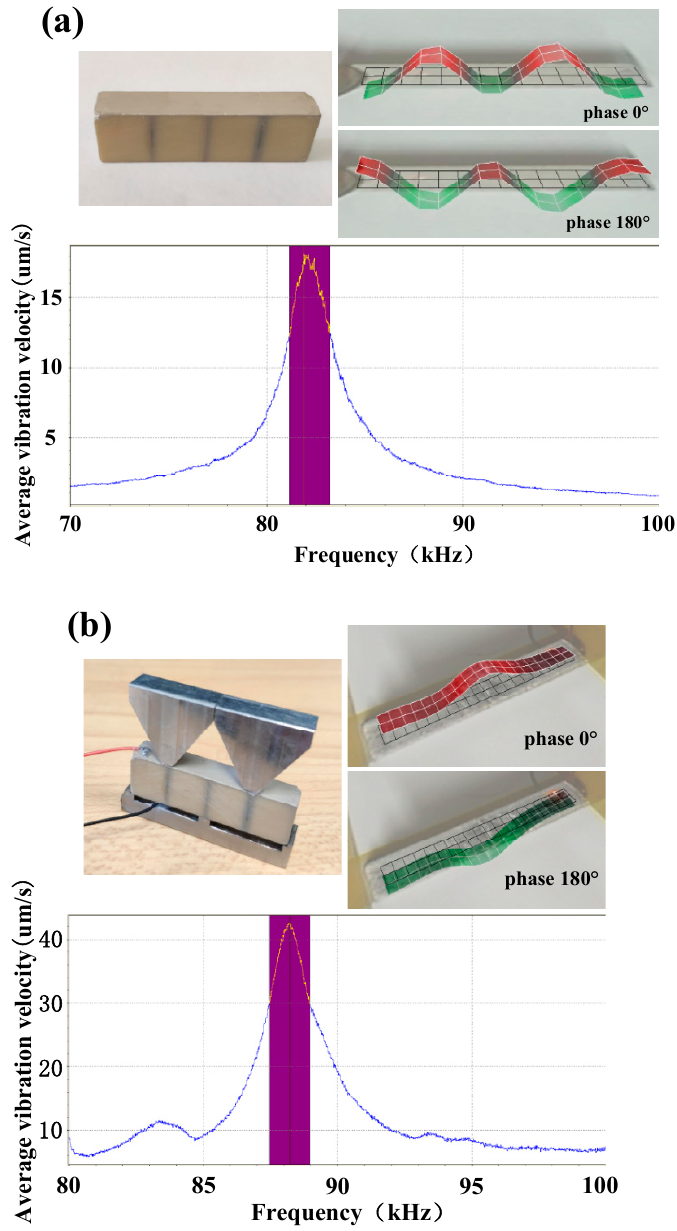
Figure 11. Laser vibration test results of piezoelectric oscillator. ( a ) Vibration situations on the surface of four elements and vibration velocity of the upper surface varying with frequency; ( b ) the vibration situations on the surface of four elements with the transition layer and vibration velocity of the upper surface varying with frequency.